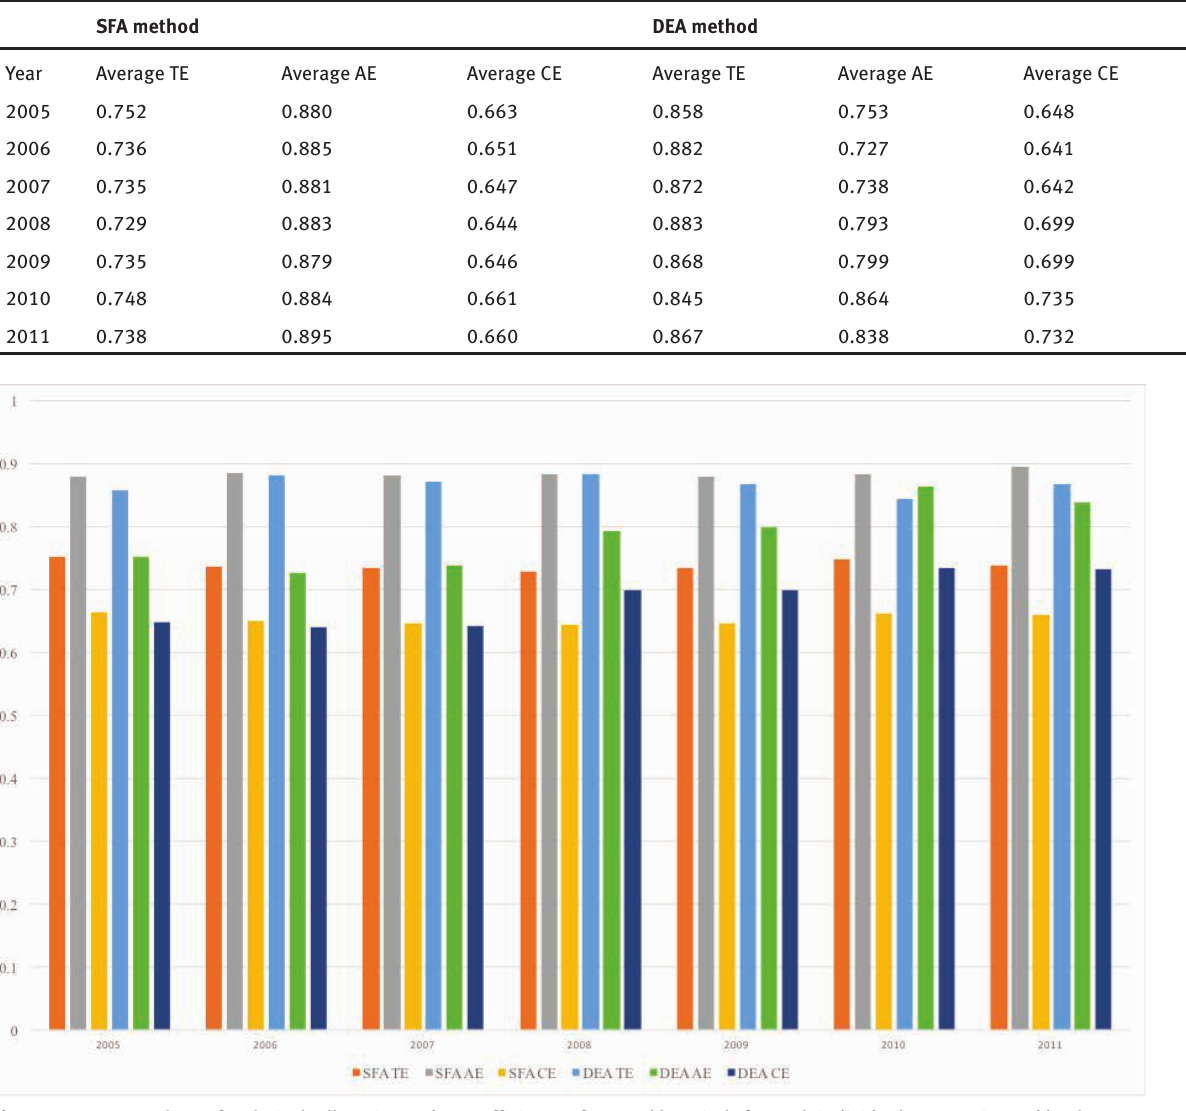
Figure 2: Average values of technical, allocative and cost efficiency of general hospitals for each individual year, estimated by the SFA method and DEA method